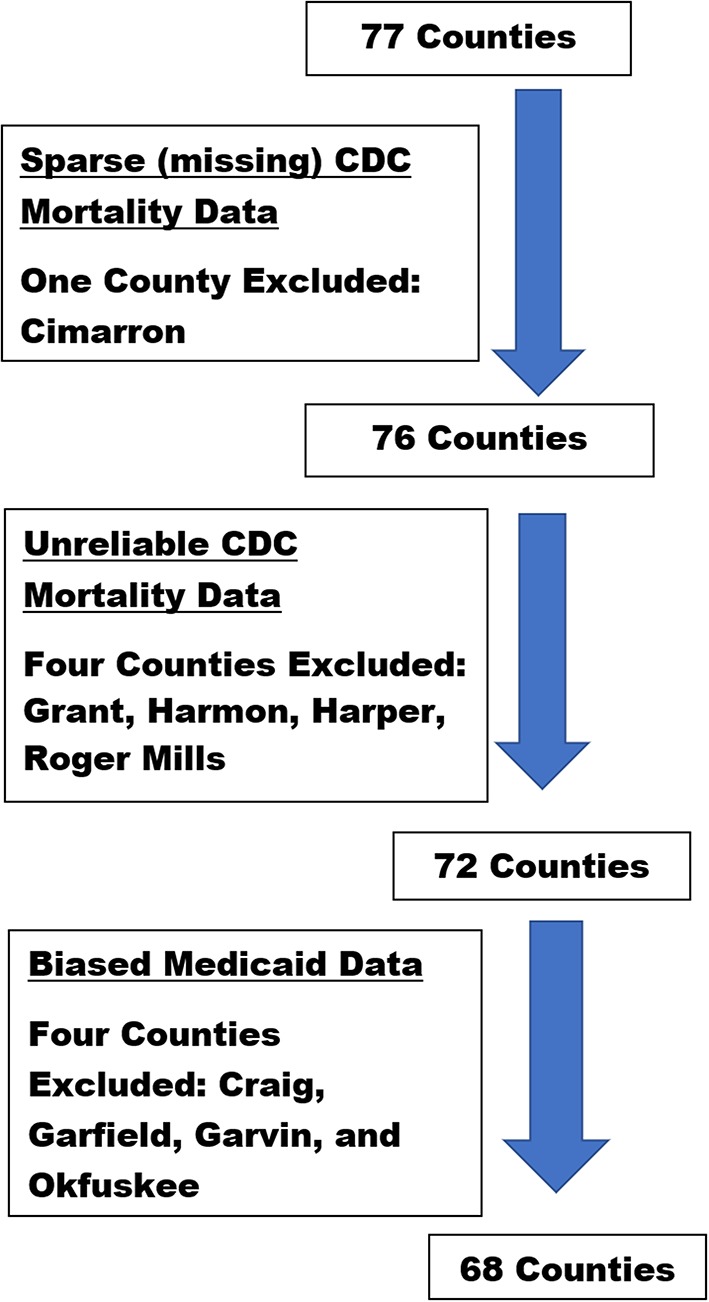
Oklahoma county-level female dataset selection process and rationale.